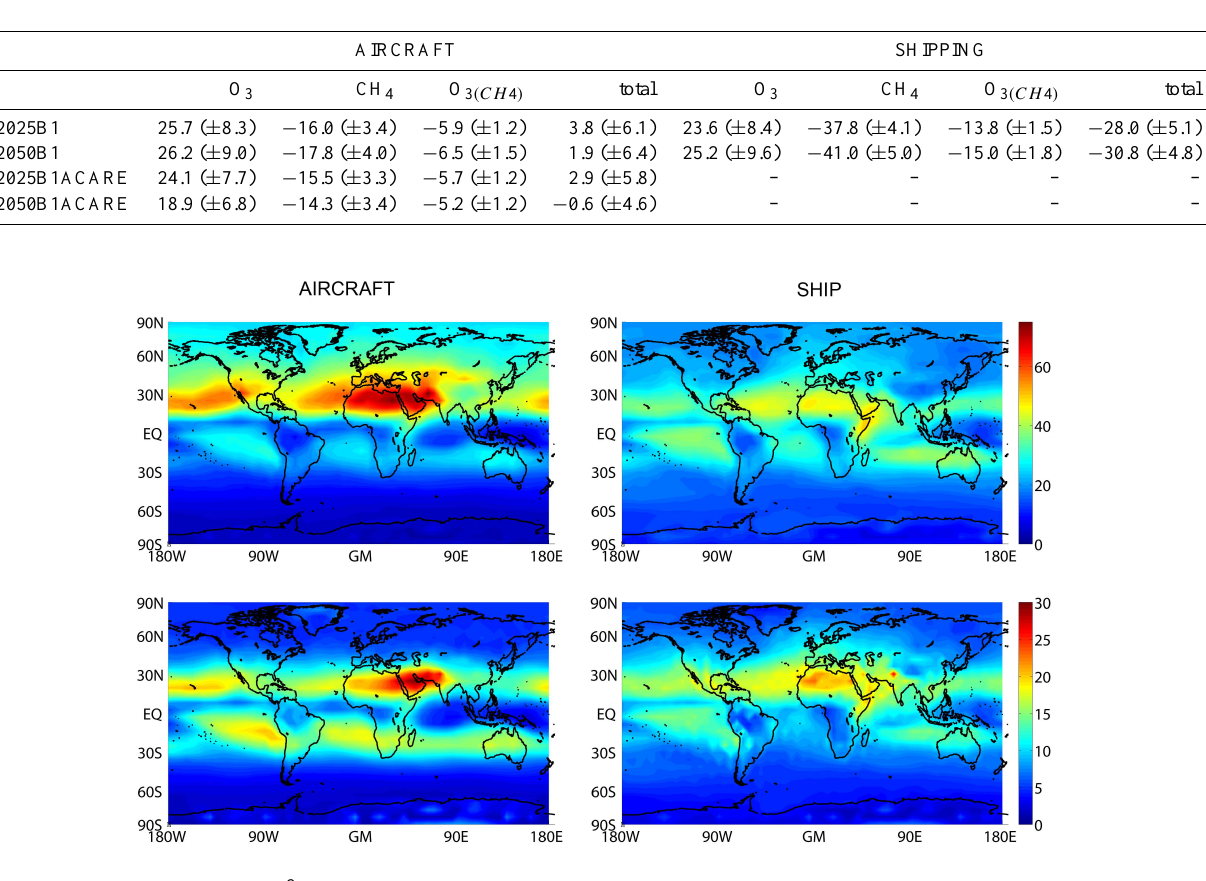
Fig. 12. Radiative forcing (mWm − 2 ) from short-term O 3 due to emissions from aircraft (left) and shipping (right), shown as ensemble mean for the 2050 B1 scenario (top) along with the absolute standard deviation (bottom). Note that the fully scaled perturbations were used to calculate the